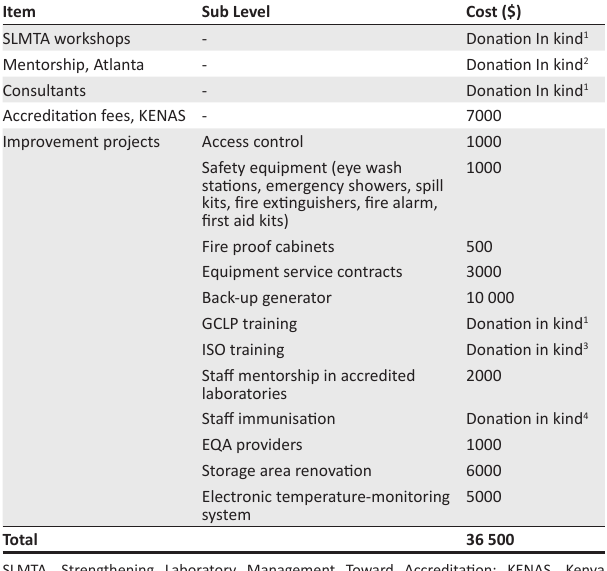
TABLE 3: Expenditures by Kenya’s National HIV Reference Laboratory to achieve ISO 15189